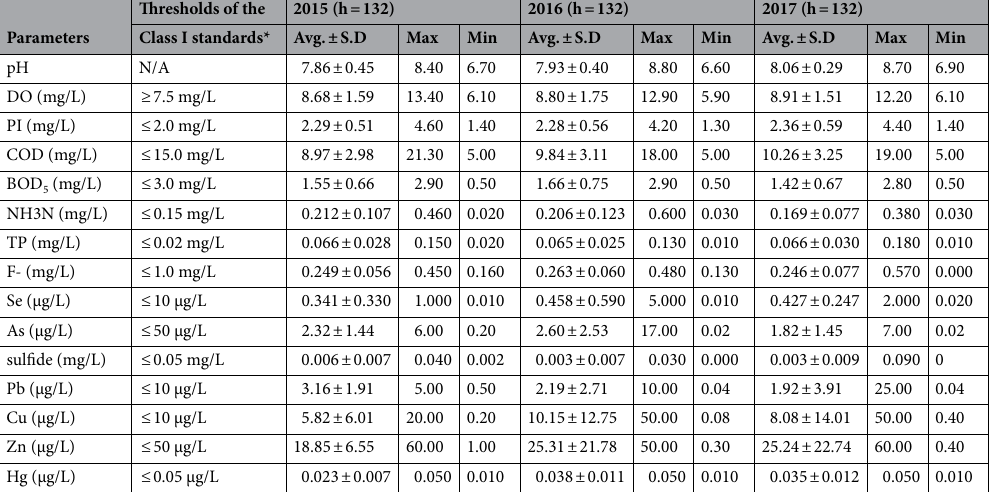
Table 1. Comparison of the variations of the water quality parameters in middle and lower reaches of Han River basin in China from 2015 to 2017 (Avg.: Average; S.D.: Standard deviation). *Data from the Environmental Quality Standards for Surface Water 39 . h is the number of the water